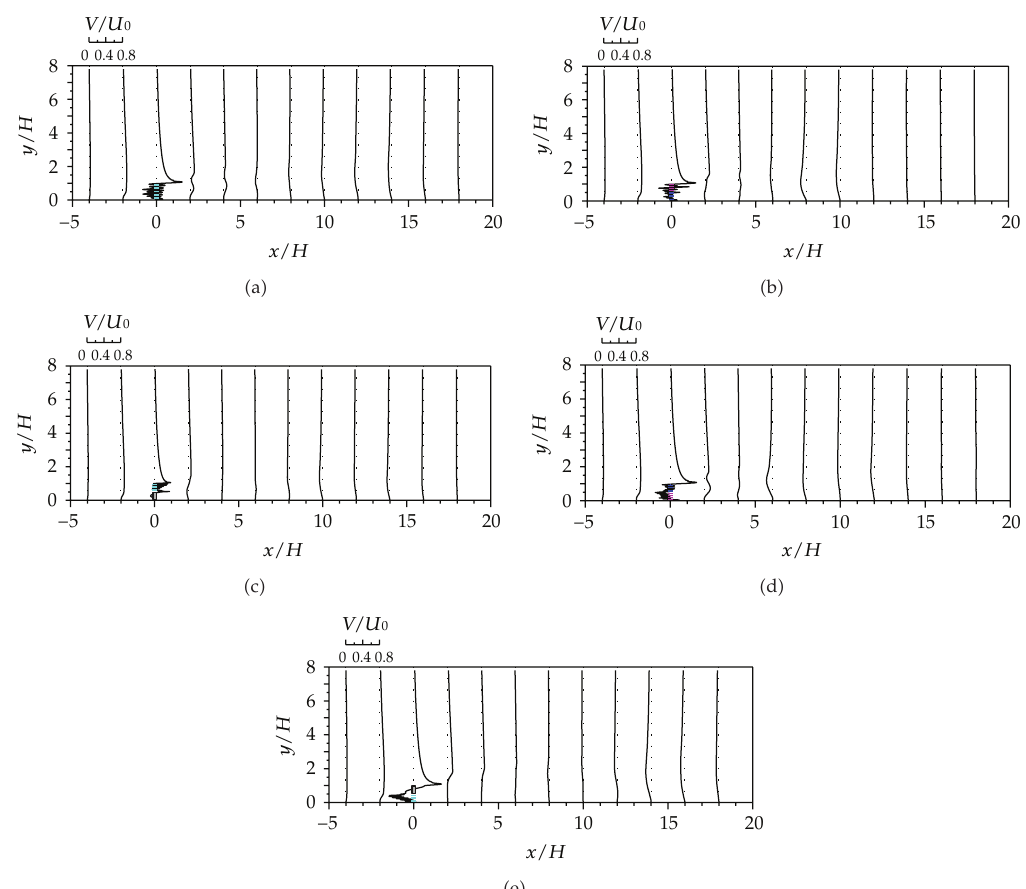
Figure 9: Variations of calculated mean vertical velocity profiles around various porous